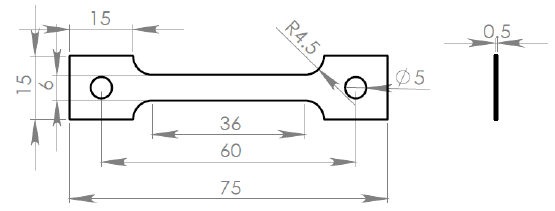
Figure 1. Dimensions of specimen for tensile tests.